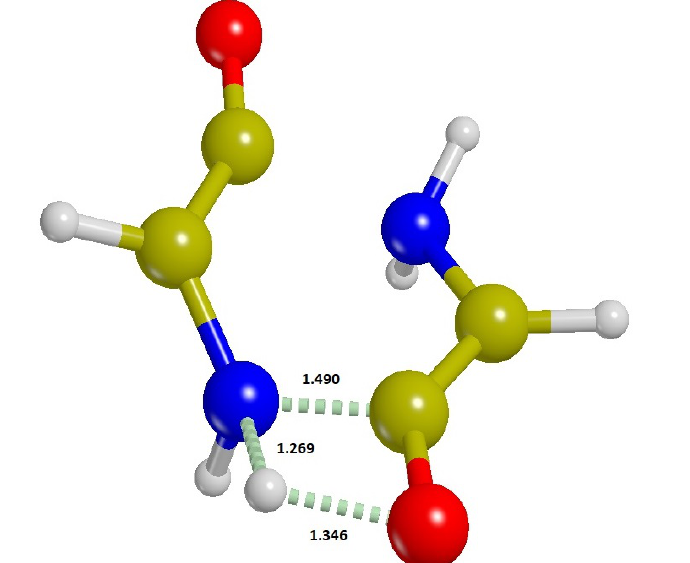
Figure 11. Transition structure for the addition of aminoketene to itself with formation of the dehydrated form of GlyGly ( 4 ). The potential energy barrier at the B3LYP/6-31G(d,p) level of theory is 16.77 kcal mol − 1 . Geometries are fully optimized, and distances are in angstroms. The formation and retention of aminoketene inside the meteorite occurs for initial velocities above ≈ 2 km s − 1 and peaks at v 0 ≈ 3.7 km s − 1 , growing monotonically with the value of the initial radius and approaching the maximum ( z / y 0 ≈ 3 × 10 − 9 ) for values R 0 = 70 µ m (Figure 12). Thus, the aminoketene formed in this range of the initial values of the radius and velocity is limited to a negligible fraction of the initial amino acid content of the micrometeoroid. As discussed above, the formed aminoketene could in turn add to glycine or to itself with formation of Gly–Gly and higher oligomers, but the minimal extent of this process does not make it a viable route to the formation of polypeptides inside